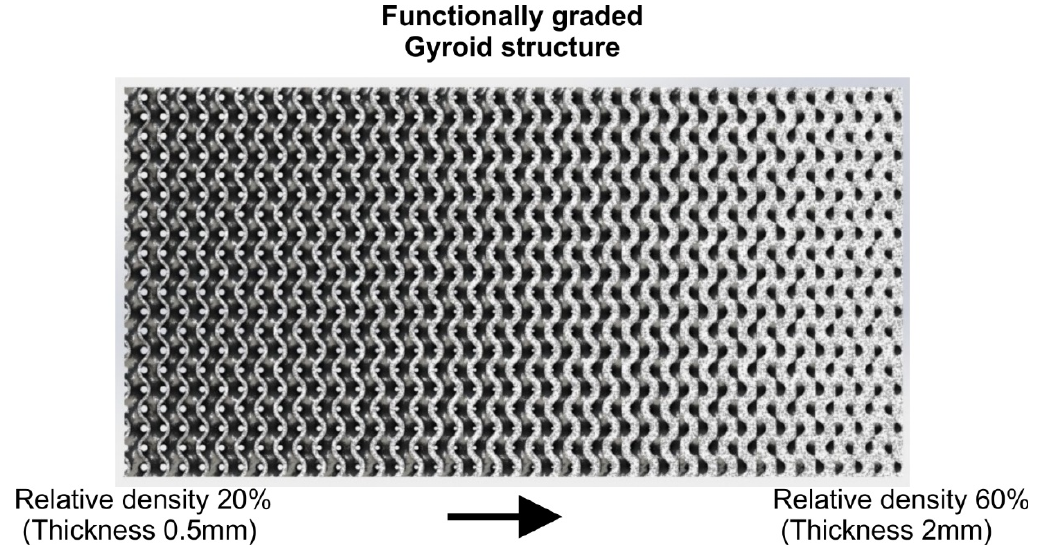
Figure 8. Graphical illustration of functionally graded Gyroid structure.